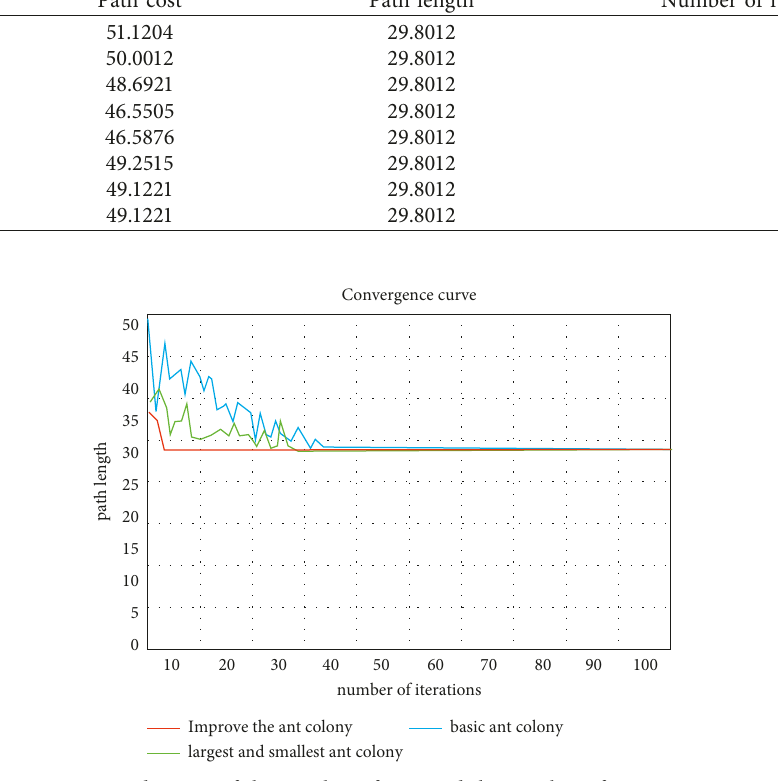
Figure 5: Curve diagram of the number of ants and the number of convergence times. Table 3: Effects of different α and β combinations on the basic ant colony algorithm.